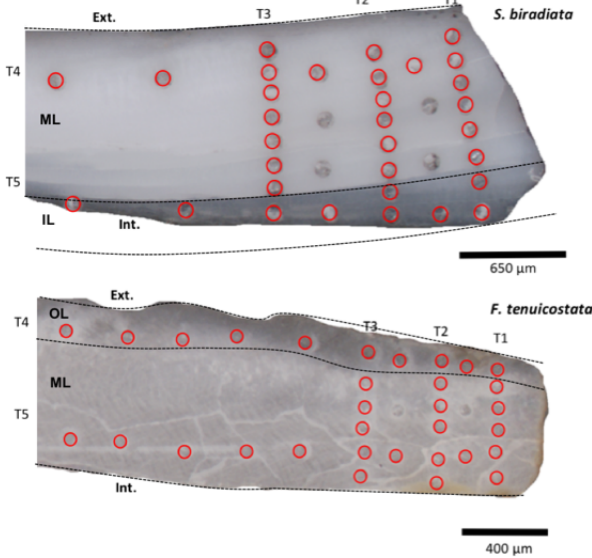
Figure 9. The location of the laser spots along the five transects. T1–T3 transect towards the inner shell surface and parallel to each other. T4 transects along the outer portion of the outer shell layer and T5 along the inner portion of the outer shell layer. The inner and outer portions of the outer shell layer are indicated by “Int.” and “Ext.”, respectively. The shell layers are indicated by OL for the outer layer, ML for the middle layer and IL for the internal layer. Note the absence of the outer shell layer and the inner shell layer in these sections of S. biradiata and F. tenuicostata , respectively. T4 and T5 were sampled from different shell layers as